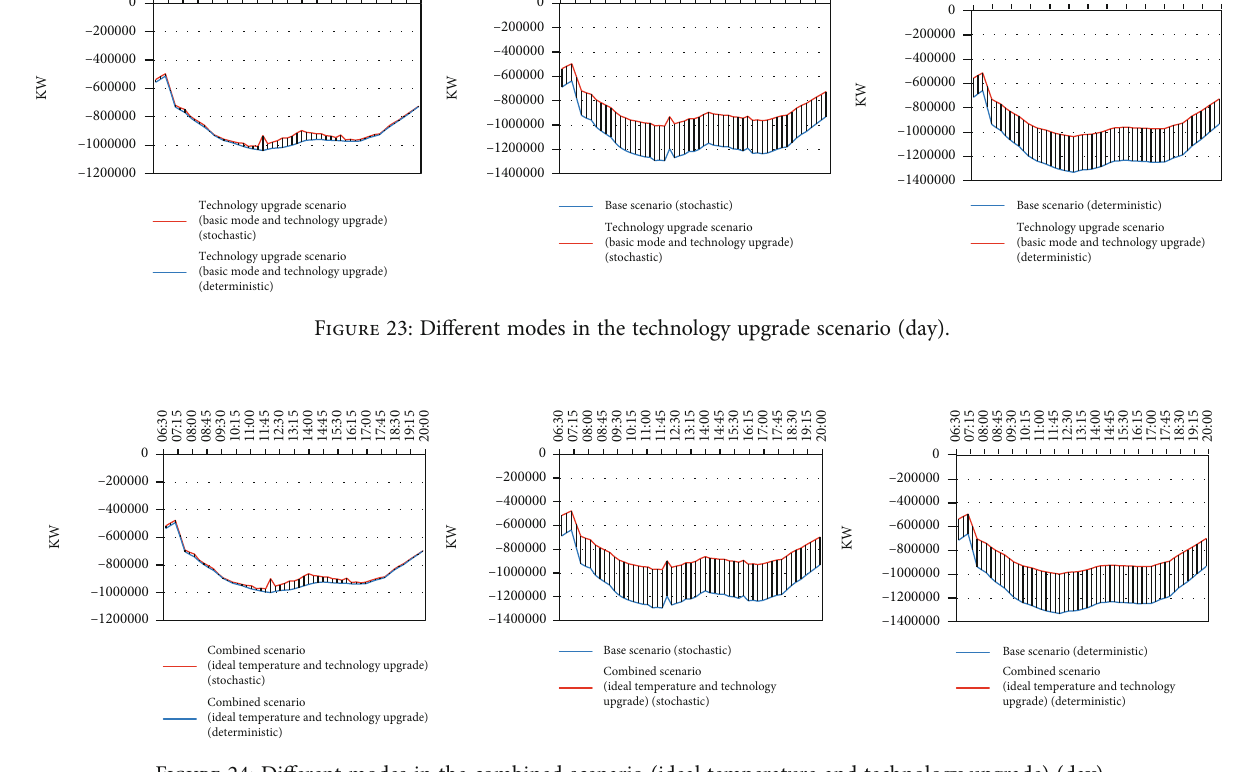
Figure 24: Di ff erent modes in the combined scenario (ideal temperature and technology upgrade) (day).